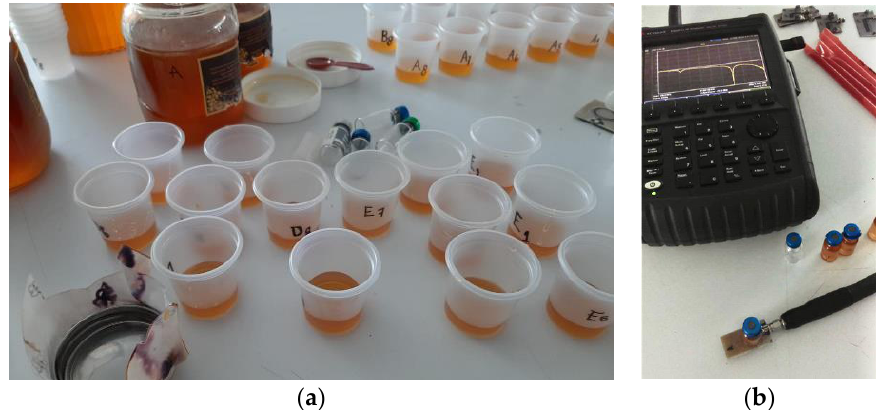
Figure 5. ( a ) A picture of some measured samples. For each of the six available honey varieties, eight samples were separated, weighted, and placed inside a plastic cup. ( b ) A picture of the measurement process where a sample is positioned on top of a sensor. The sensor is connected to a N9914A-21 Vector Network Analyzer (VNA) by means of a low loss precision test cable of the frequency response can be seen on the screen of the VNA.